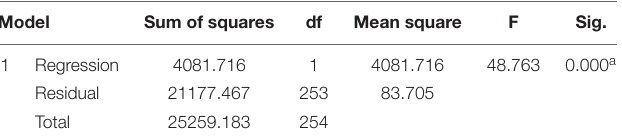
TABLE 7 | ANOVA for regression.